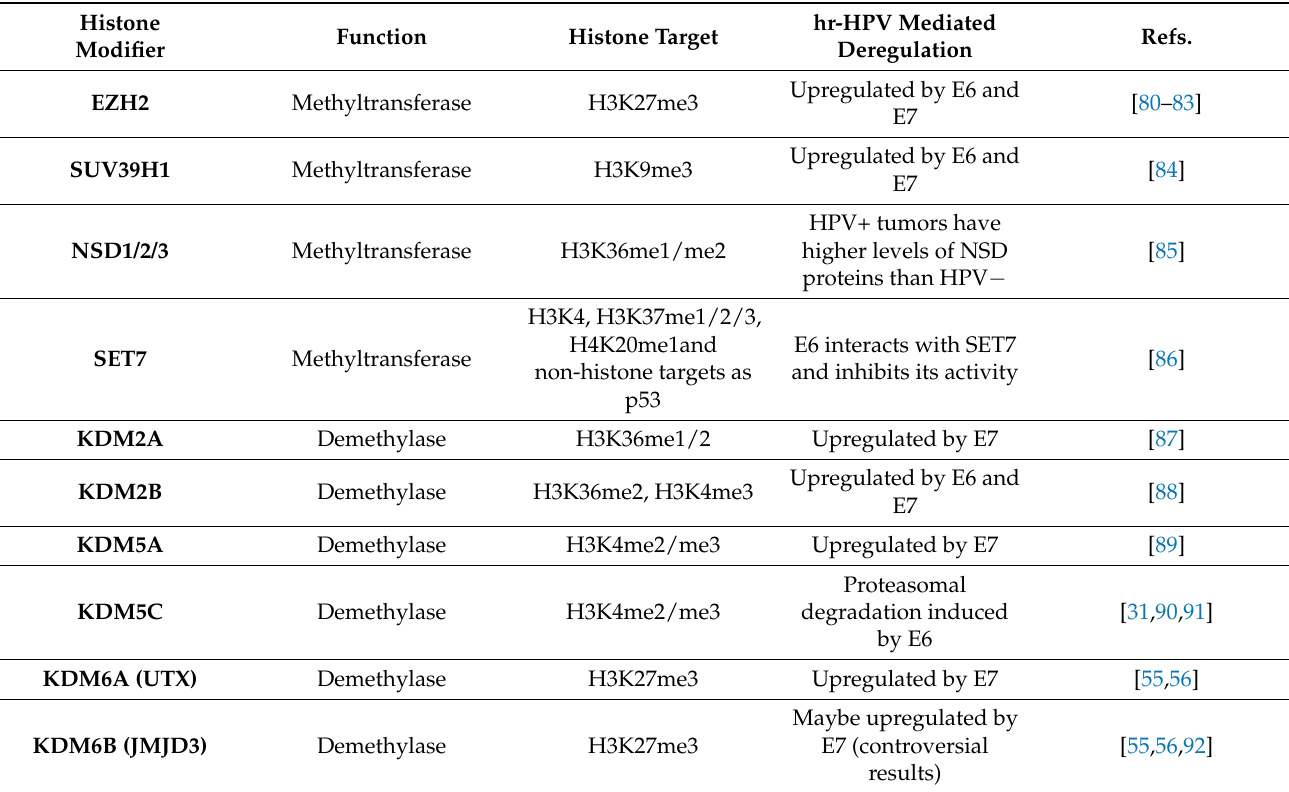
Table 4. Hr-HPV E6/E7-mediated regulation of histone modifiers responsible for the deposition or removal of methylated